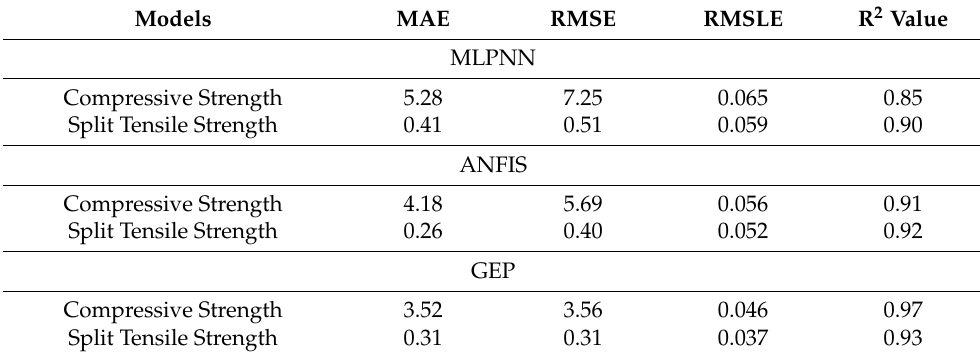
Table 8. Statistical Errors in Validation Stages for the Models.